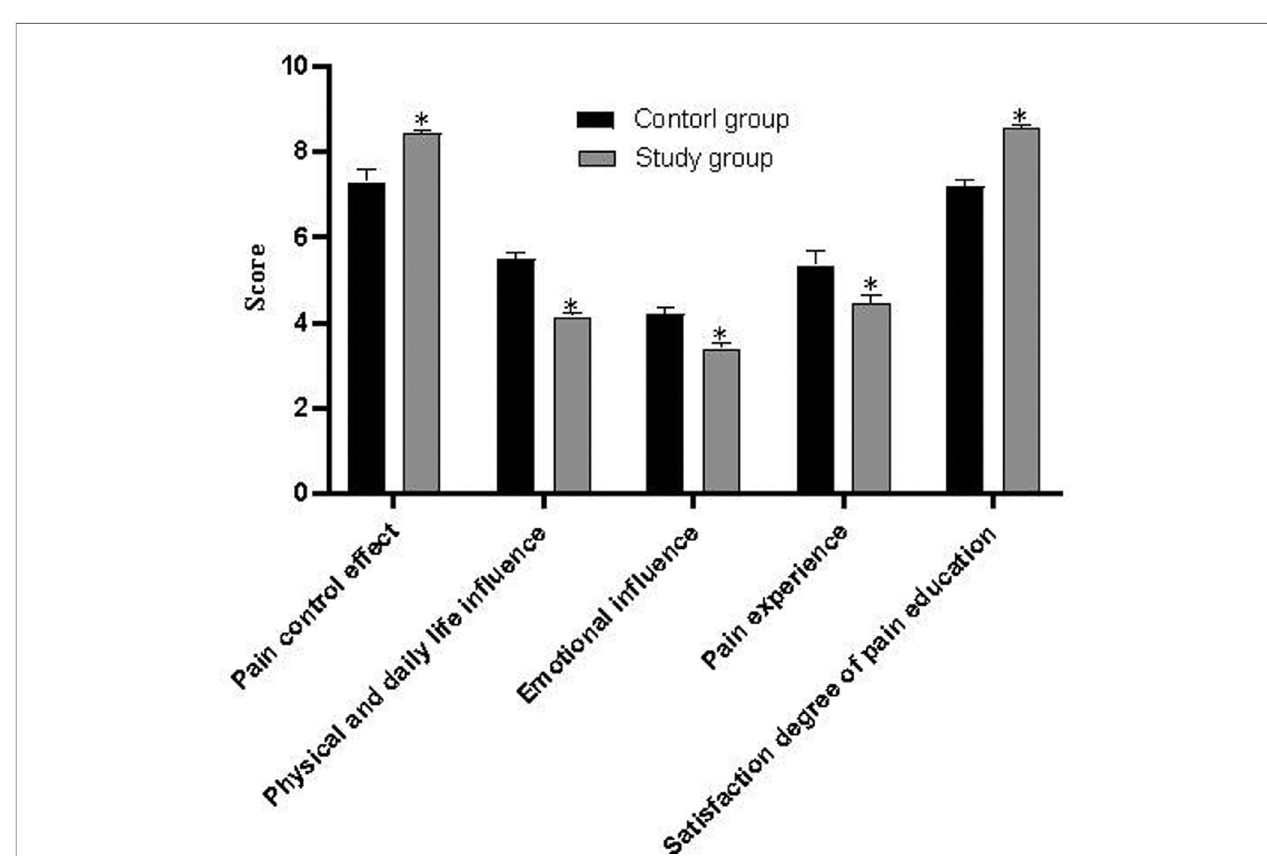
FIGURE 1 | Comparison of HPOI scores between the two groups.